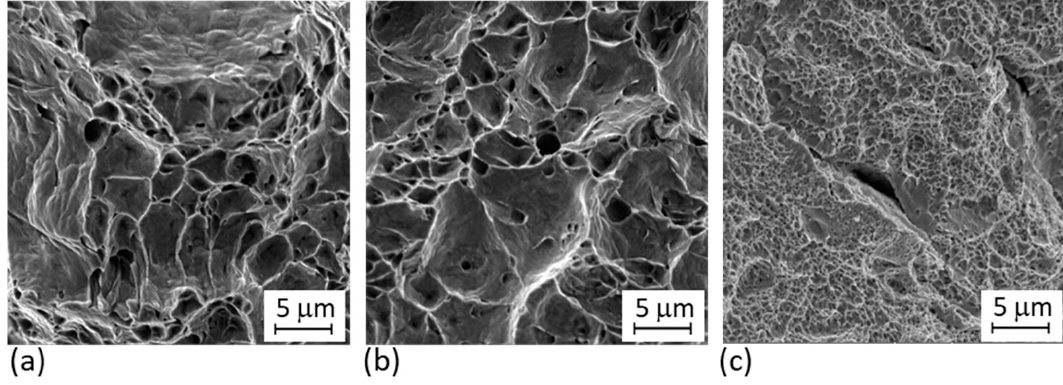
Figure 16. Detail of metallographic sections from the fracture region of hybrid parts: ( a ) without heat treatment; ( b ) solution annealed; ( c ) precipitation annealed. It was only in the precipitation annealed part that the fracture occurred in the additively manufactured steel.